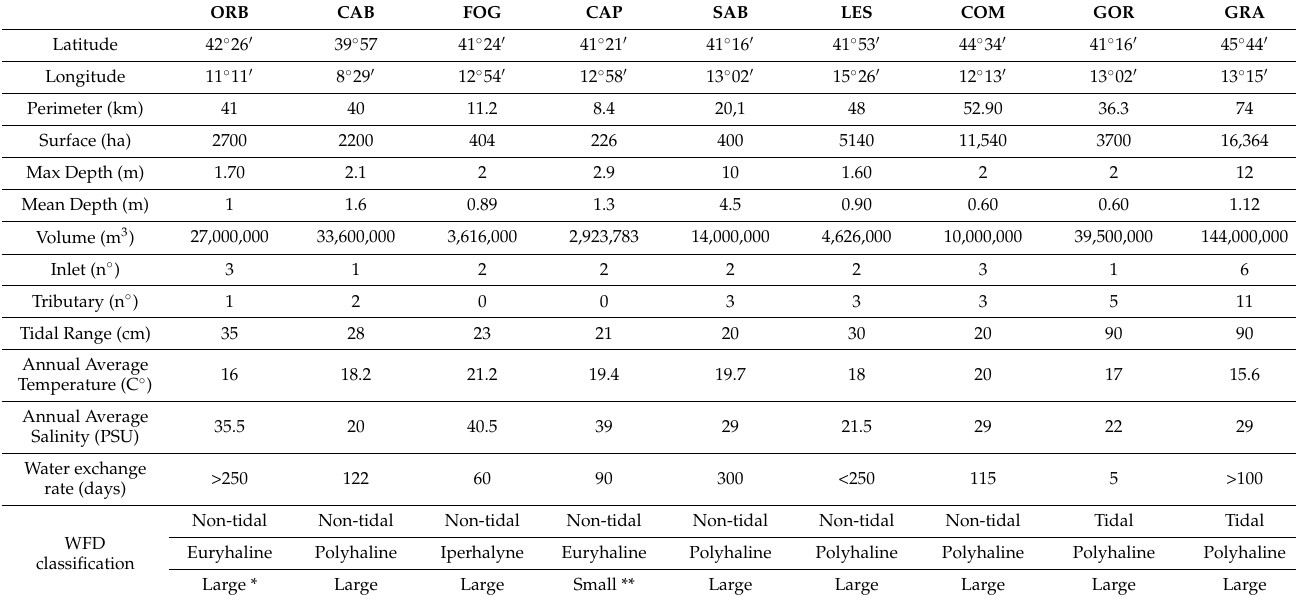
Table 1. Main geo-morphological and hydrographic features of coastal lagoons under study. (ORB) Orbetello, (CAB) Cabras, (FOG) Fogliano, (CAP) Caprolace, (SAB) Sabaudia, (LES) Lesina, (COM) Comacchio, (GOR) Sacca di Goro, (GRA) Grado Marano.